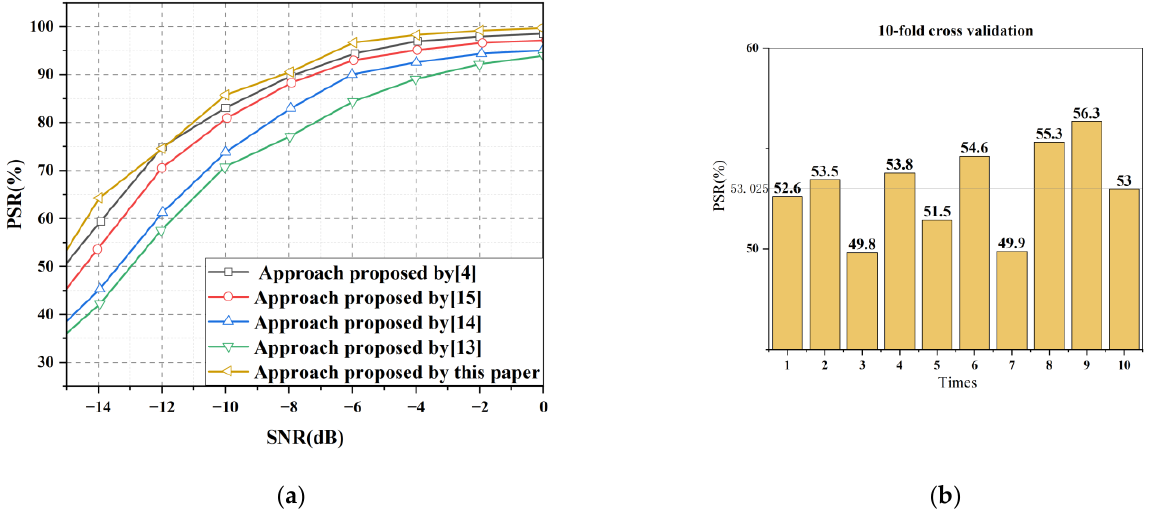
Figure 15. ( a )comparison between the proposed multisignal recognition framework and CNNs in other papers. ( b ) 10-fold cross- validation of −15 dB mixed signals. other papers. ( b ) 10-fold cross-validation of − 15 dB mixed